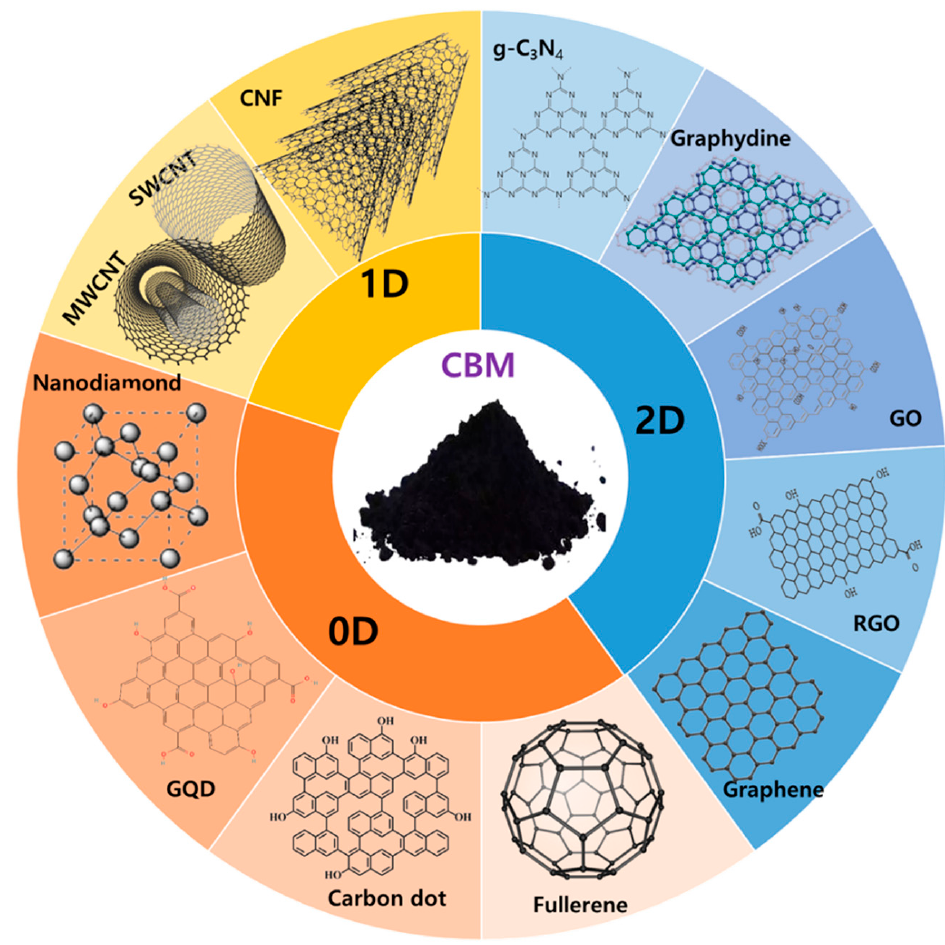
Figure 1. Graphical representation of the different dimensions of carbon-based nanomaterials.